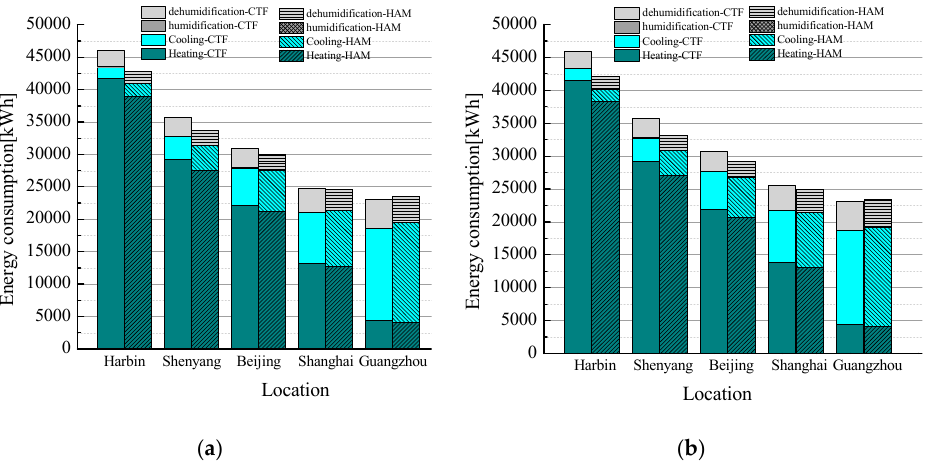
Figure 9. Different parts of energy consumption in the official building in different area: ( a ) EPS; ( b ) rock wool.